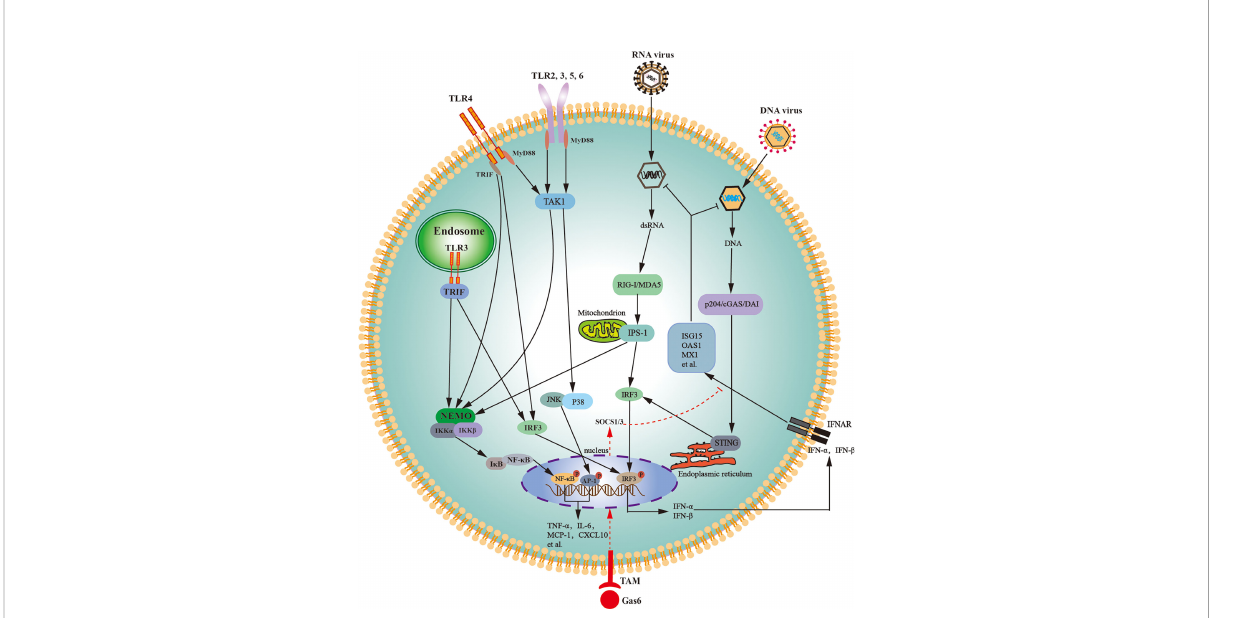
FIGURE 3 Schematic of the innate immune signaling pathways in Leydig cells. Various toll-like receptors (TLRs), except for TLR3 and TLR4, initiate the MyD88-dependent signaling pathway. TLR3 initiates the TRIF-dependent pathway, whereas TLR4 initiates both MyD88- and TRIF-dependent pathways. The MyD88-dependent pathway induces the expression of proin fl ammatory cytokines (TNF- a , IL-6) and chemokines (MCP-1, CXCL10) through activation of NF- k B and AP-1. The TRIF-dependent pathway induces the expression of proin fl ammatory cytokines, chemokines, and type 1 interferons (IFN- a and IFN- b ) via the activation of NF- k B and IRF3. Cytosolic RNA sensors RIG-I and MDA5 initiate innate antiviral responses through the activation of IPS-1 located on the outer membrane of the mitochondria. The IPS-1-dependent pathway induces the expression of proin fl ammatory cytokines and chemokines through NF- k B activation and also induces the expression of type 1 interferons through IRF3 activation. DNA sensors p204, cGAS, and DAI trigger antiviral responses through the activation of STING localized in the endoplasmic reticulum. The STING-dependent signaling pathway predominantly induces type 1 interferon expression. Type 1 interferons induce the expression of the antiviral proteins, including ISG15, OAS1, and MX1, in autocrine and paracrine manners. Tyro3, Axl and Mer receptor tyrosine kinases (TAM) can be activated by their common ligand Gas6, which initiates signaling pathway to induce the expression of SOCS1/3, and SOCS1/3 inhibit IFN-triggered antiviral responses. AP-1, activator protein 1; cGAS, cyclic GMP-AMP synthase; CXCL10, C-X-C motif chemokine ligand 10; DAI, DNA-dependent activator of IFN regulatory factors; Gas6, growth-arrest-speci fi c gene 6; IL-6, interleukin-6; IPS-1, IFN- b promoter stimulator 1; IRF3, interferon regulatory factor 3; JNK, Jun amino-terminal kinase; ISG15, IFN-stimulating gene 15; MCP-1, monocyte chemotactic protein 1; MDA5, melanoma differentiation-associated protein 5; MX1, MX GTPase 1; MyD88, myeloid differentiation protein 88; NEMO, NF- k B-essential modulator; IKK, I k B kinase; NF- k B, nuclear factor kappa B; OAS1, 2 ’ 5 ’ -oligoadenylate synthetase 1; p204, IFN-inducible protein in mouse; RIG-I, retinoic acid-inducible gene I; SOCS, suppressor of cytokine signaling; STING, stimulator of IFN gene; TRIF, toll/IL-1R domain-containing adaptor inducing IFN- b ; TAK1, Transforming-growth-factor-beta-activated kinase; TNF- a , tumor necrosis factor- a